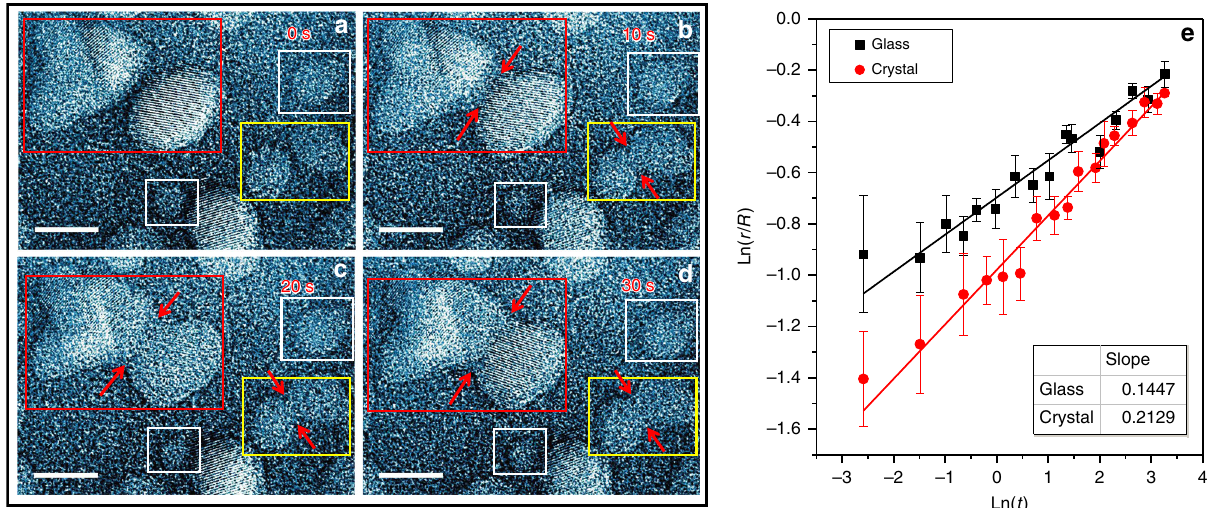
Fig. 2 Coalescence of amorphous and crystalline nanoparticle pairs at 738 K. a – d Video of sequential images showing particles coalescence of amorphous PdSi particle pair (in yellow rectangle) and crystalline particle pair (in red rectangle) at 738 K. The stability of small particles in white rectangles demonstrates that the effect of Ostwald ripening effect is negligible. Scale bar: 5 nm. e The evolution of neck diameter as a function of time of crystalline- crystalline and amorphous-amorphous particles. The data are fi tted using least-squares approximation, with the fi tted slopes shown in the inset table. Error bar represents standard deviation of 12 measurements of the neck width in corresponding